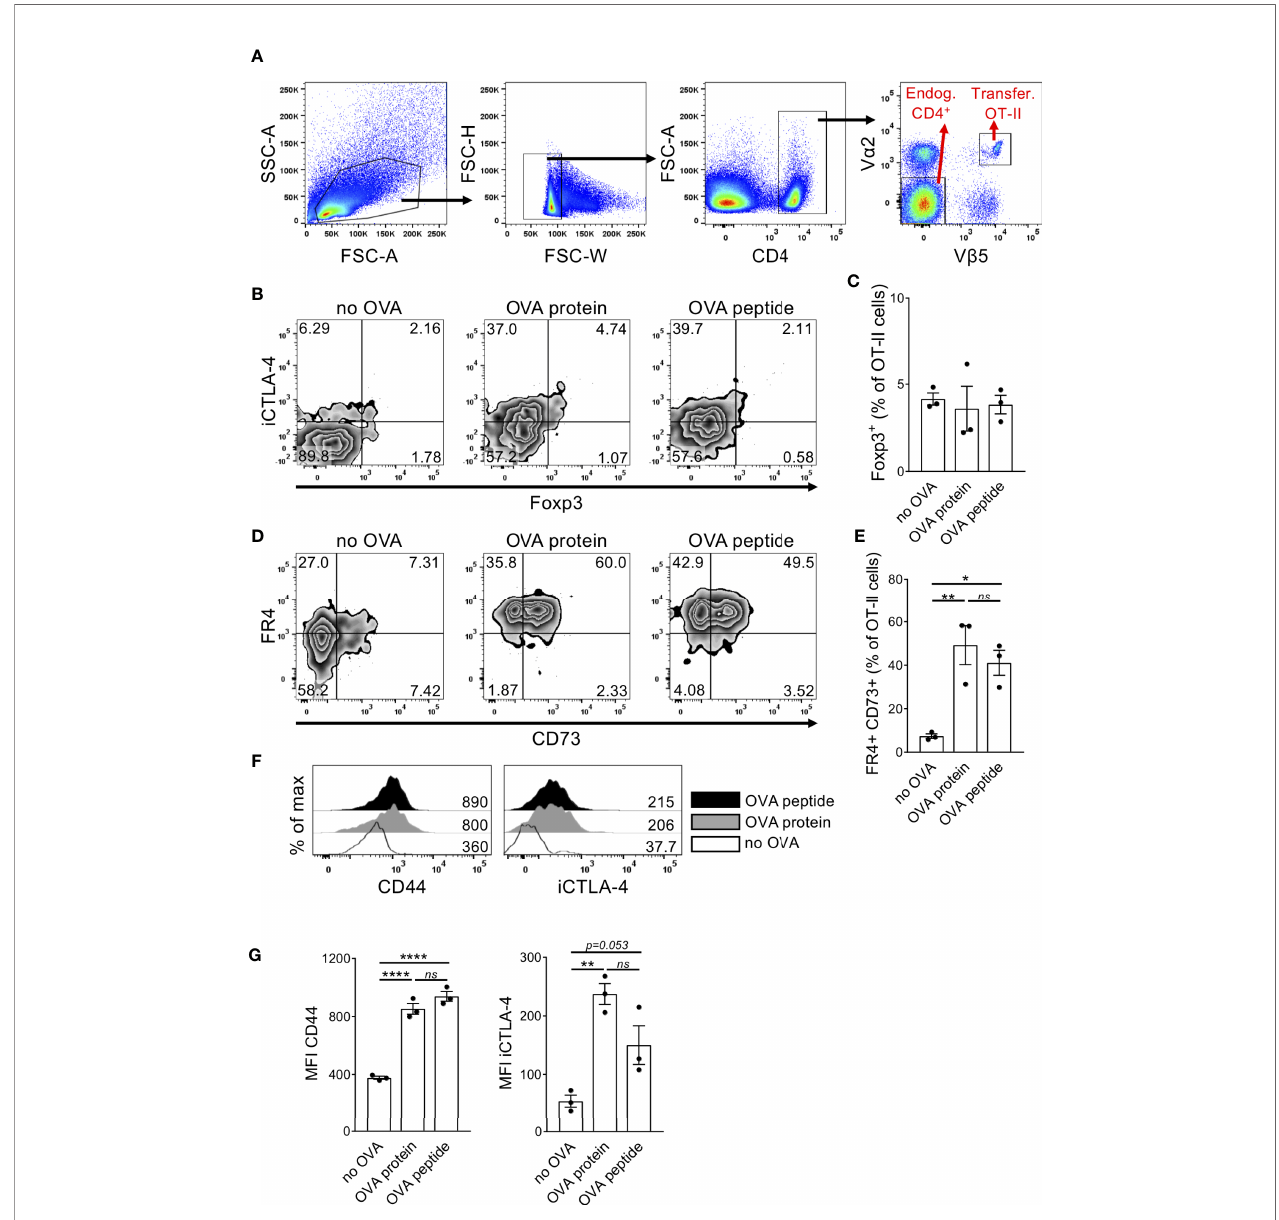
FIGURE 1 | Adoptively transferred naïve T cells upregulate different anergy markers after high dose OVA injection. Transferred OT-II cells isolated from the spleen of recipient mice were tested for expression of different anergy markers 5 days after i.v. OVA 327-339 peptide or OVA protein injection. (A) Gating strategy. Cells were fi rst gated on living singlets. Within the CD4 + population, injected OT-II cells can be identi fi ed by co-expression of TCR V a 2 and V b 5 chains, while V a 2 - V b 5 - CD4 + T cells were chosen as endogenous control cells. (B) Representative FACS plots show expression of intracellular CTLA-4 (iCTLA-4) and Foxp3 in transferred OT- II cells. (C) Quanti fi cation of the frequency of Foxp3+ cells in transferred OT-II cells. (D) Representative FACS plots show co-expression of FR4 and CD73. (E) Quanti fi cation of the frequency of FR4 + CD73 + double-positive cells in transferred OT-II cells as mean ± SEM. (F) Representative histogram overlays show marker expression in transferred OT-II cells from non-injected (white), OVA 327-339 protein-injected (grey) or OVA peptide-injected (black) mice. Numbers indicate median fl uorescence intensities (MFIs). (G) Expression of anergy markers is shown as MFI within OT-II cells summarized as mean ± SEM. Dots represent individual mice. *p < 0.05, **p < 0.01, ****p < 0.0001, one-way ANOVA with Tukey post-test. ns, not signi fi